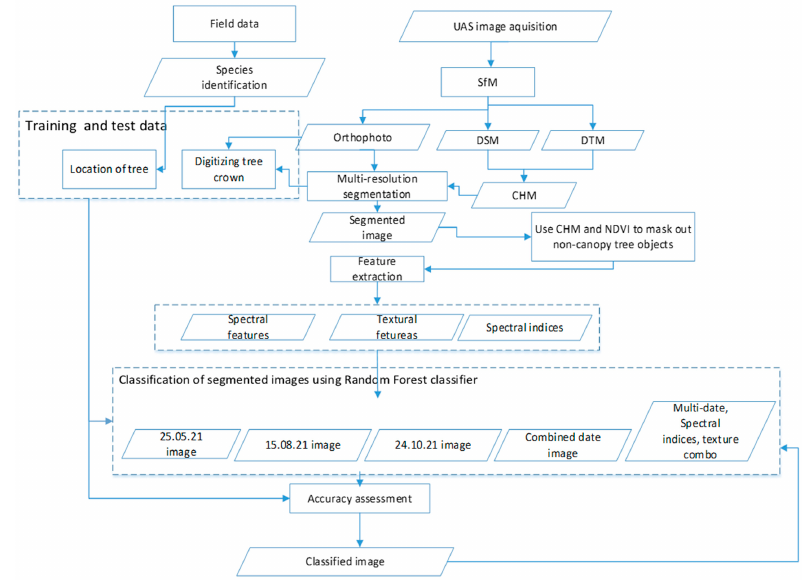
Figure 1. General UAS image acquisition, processing, and classification workflow.